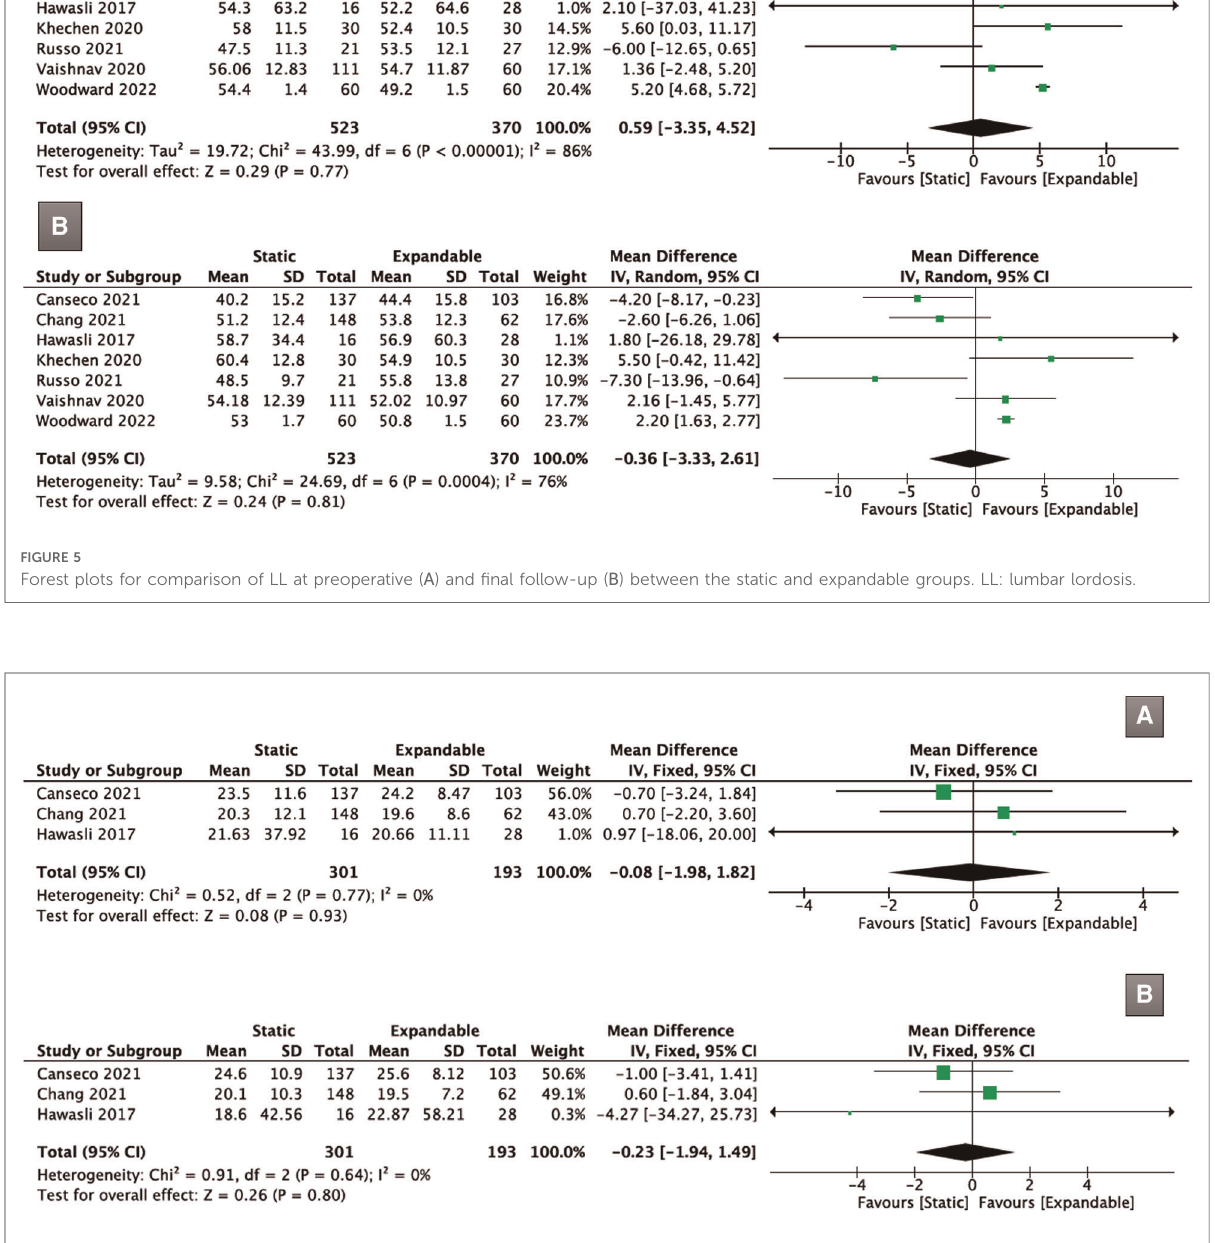
signi fi cantly higher in the expandable group than in the static group (WMD, 0.69; 95% CI, 0.18, 1.20; I 2 = 56%; P = 0.008; Figure 10C ), there was no signi fi cant difference between the static and expandable groups at the fi nal follow-up (WMD,